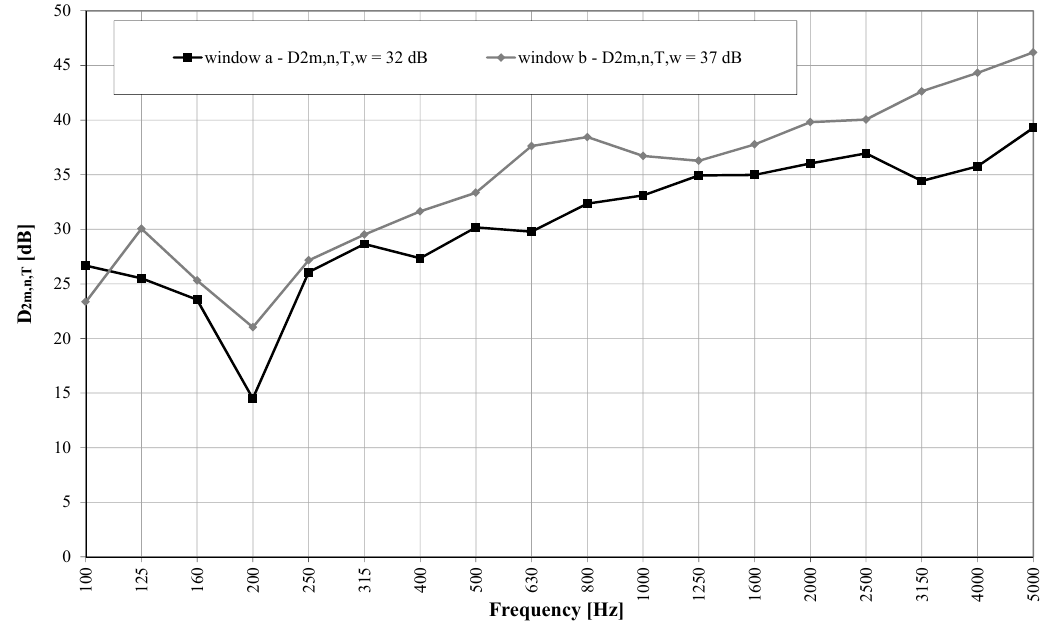
Figure 9. Façade sound insulation ( D type of